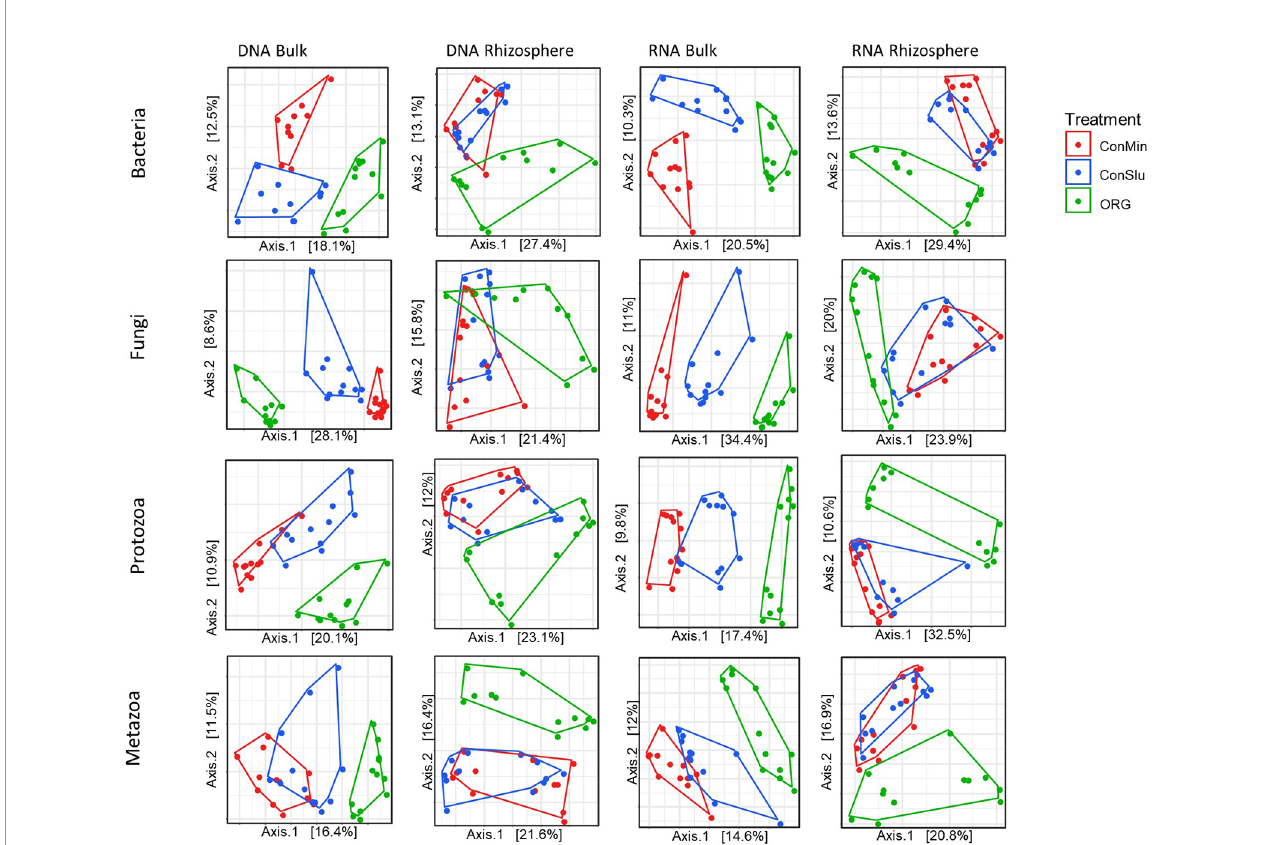
FIGURE 3 | Principal coordinate analysis (PCoA) ordination of a Bray-Curtis dissimilarity matrix. Plots illustrate distances between communities for each of the organismal groups under three different soil management types [ConMin (red), ConSlu (blue), and Organic (green)]. Split plots per organismal group for DNA bulk, DNA rhizosphere, RNA bulk, and RNA rhizosphere.